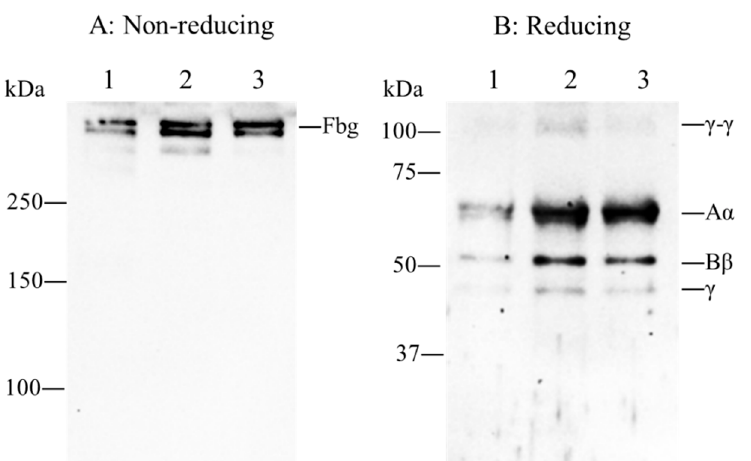
Figure 1. Immunoblotting analysis of plasma fibrinogen. One thousand-fold diluted plasma was separated by sodium dodecyl sulfate (SDS)-polyacrylamide gel electrophoresis (PAGE) in non-reducing conditions in a 7% polyacrylamide gel ( A ) or reducing conditions in a 10% polyacrylamide gel ( B ) and plasma fibrinogen was detected by Western blotting using an anti-human fibrinogen antibody. Fibrinogen (Fbg), γ - γ dimer and A α , B β , and γ chains are indicated on the right side of each panels. Lane 1: purified normal plasma fibrinogen, 2: normal plasma, 3: patient’s plasma.